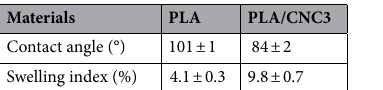
Table 2. Contact angle and swelling index of PLA and PLA/CNC scaffolds.